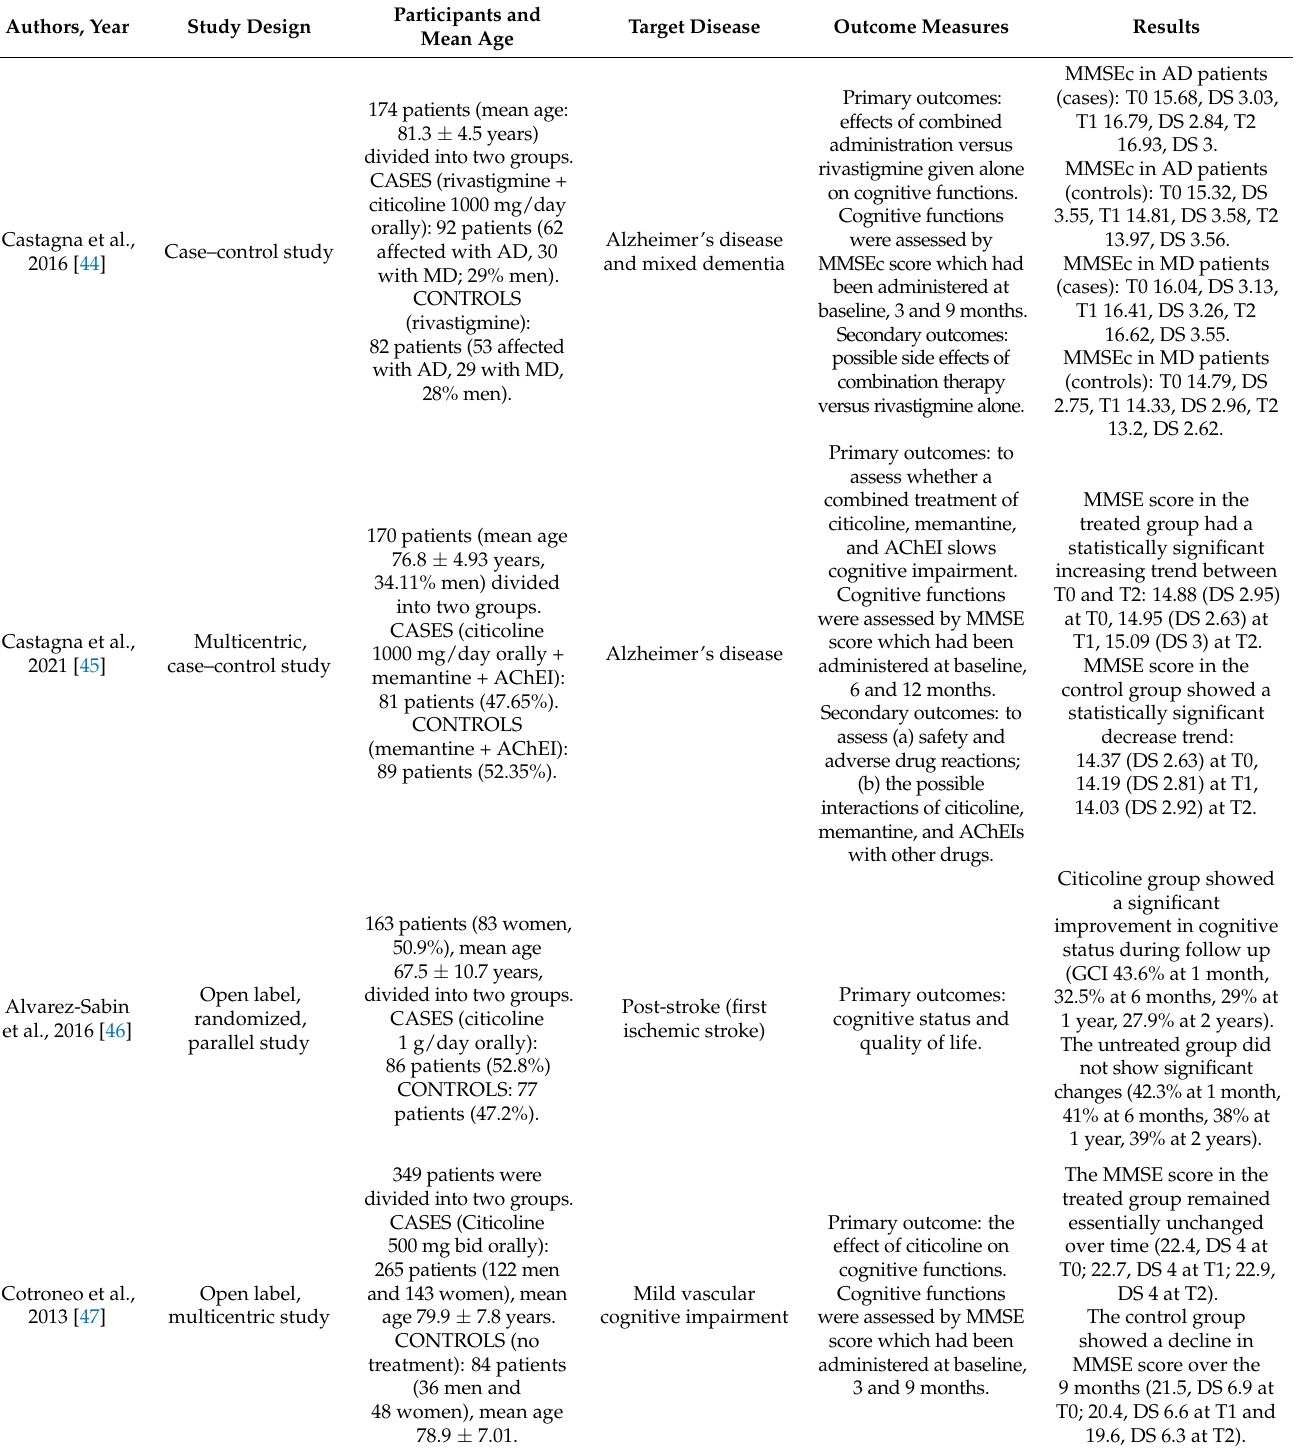
Table 2. Characteristics of the studies